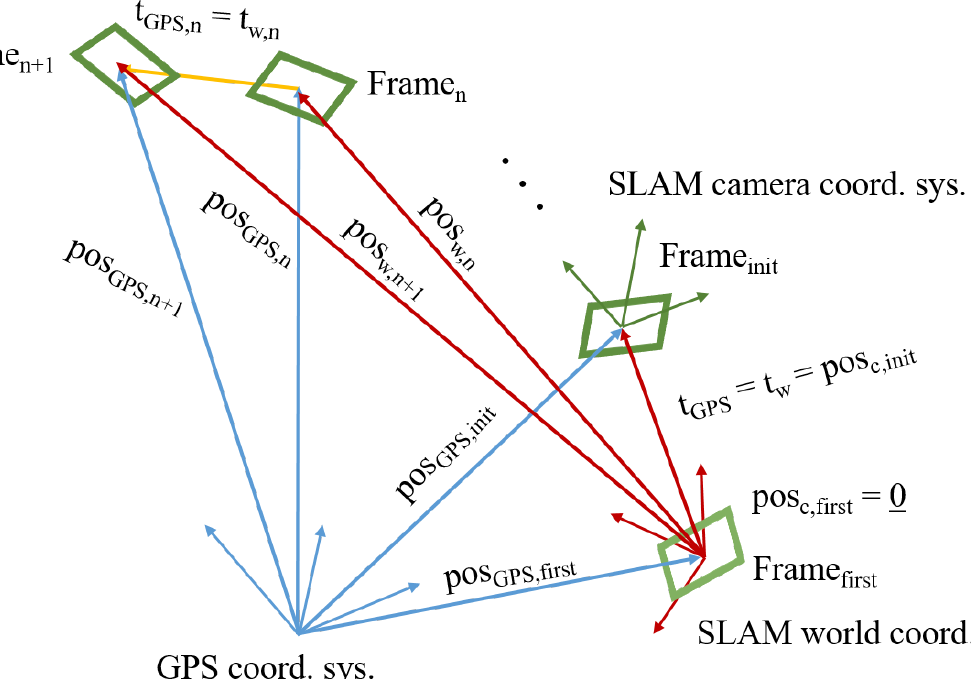
Figure 2. The coordinate systems and vectors of the